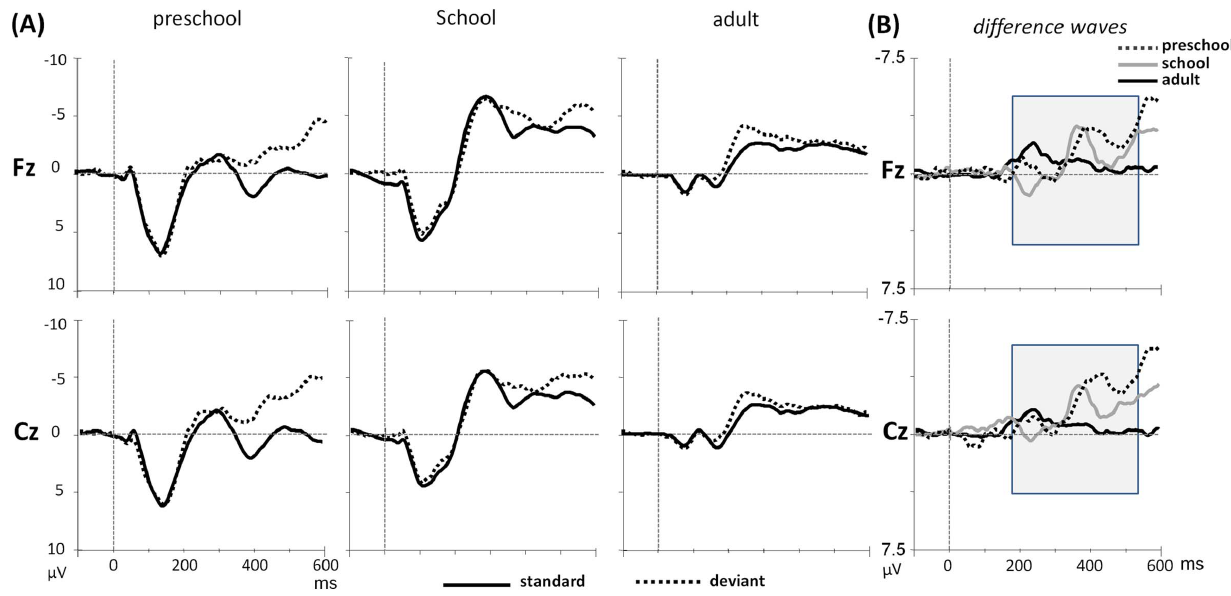
Figure 3. (A) Grand average waveforms of the standard and deviant stimuli at midline electrodes (Fz & Cz), and (B) difference waveforms across three age groups to lexical tone